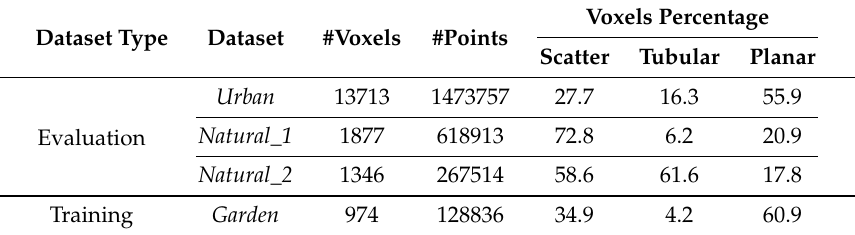
Table 1. Characteristics of hand labeled voxels of experimental point